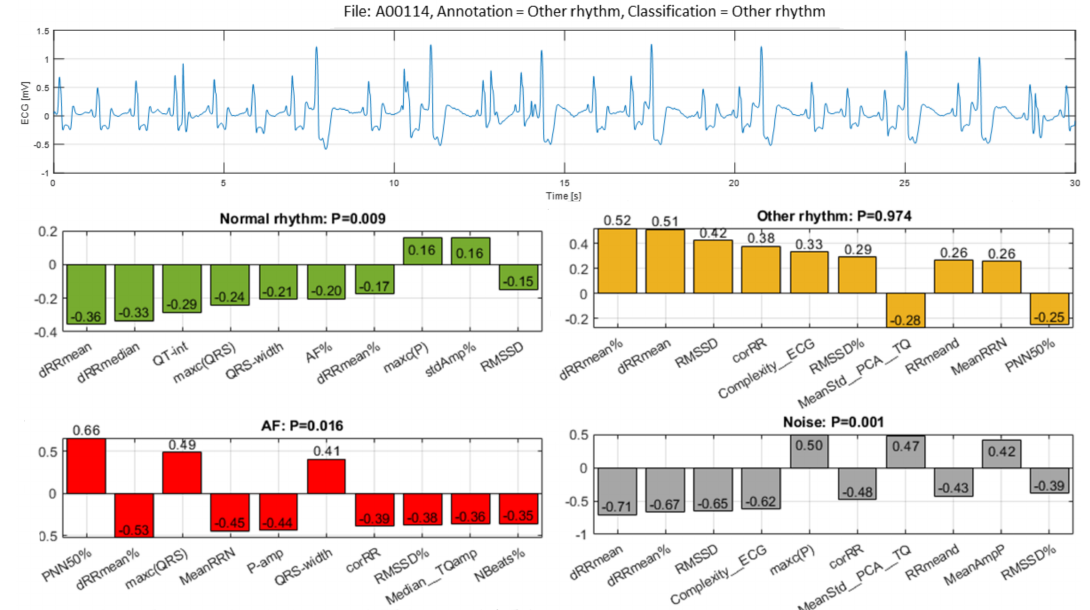
Figure 15. ECG example (file A00114) of correctly classified Other rhythm. The single-lead ECG strip is representative to sinus rhythm with alternating ventricular tri-, quadri- and bi-geminy and a widened baseline QRS as in fixed bundle-branch block. Some of the baseline wide QRS are changed additionally due to artifacts, and they might mislead ventricular ectopy. The barplots represent the Case Feature Importance of the top-10 ranked features, which maximally contributed to the output classification probability (P) in four rhythms. The ECG strip is definitively detected as Other rhythm (P = 0.974) by DenseNet-3@128-32-4 model based on HRV and ECG complexity features.